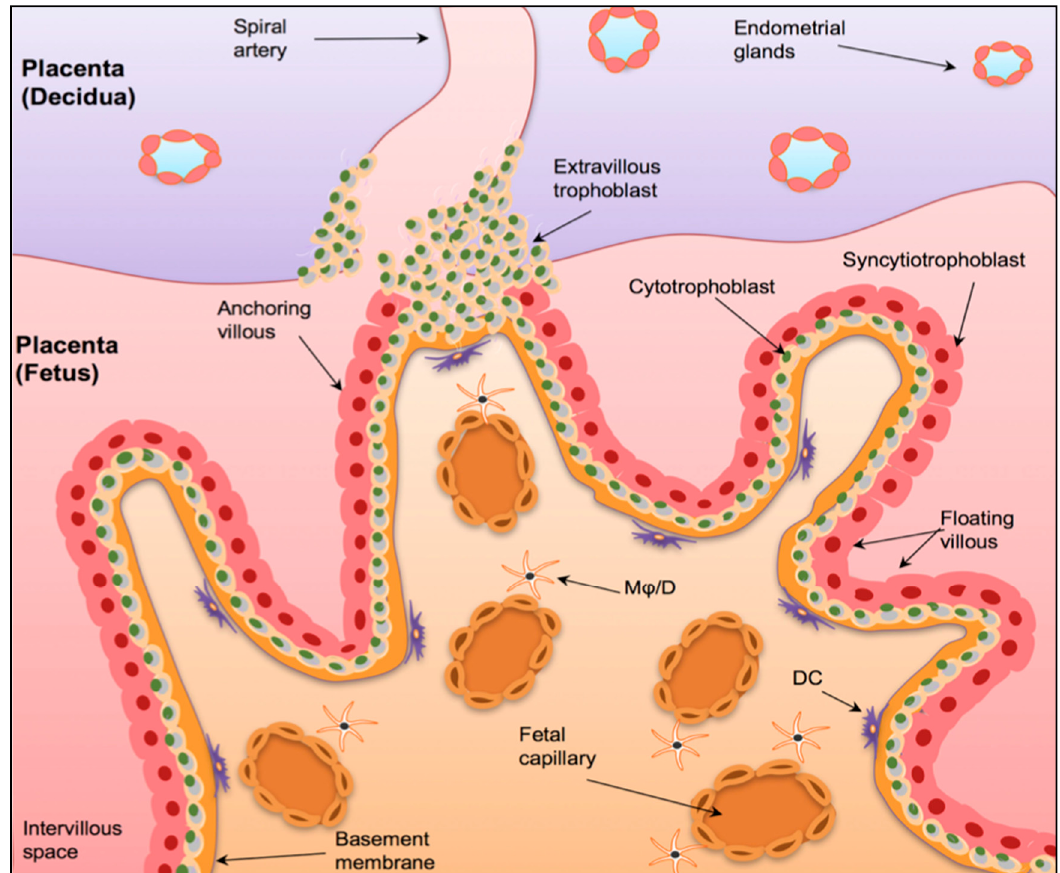
Figure 1. The Maternal-Foetal Interface. A graphical representation of the maternal-foetal interface in the placenta. The human placenta is formed by a foetal component, mainly containing chorionic villi and a maternal component (the decidua), consists of spiral arteries. The chorionic villi have a basal membrane that is anchored to inner cytotrophoblast epithelium (CBT), which in turn fuse to form the outer syncytiotrophoblast layer (STB). The anchoring villi invade the uterine wall via extravillous trophoblasts (EVT). M ϕ / D = macrophages / dendritic cells. DC = dendritic cells. Taken with permission from [25].